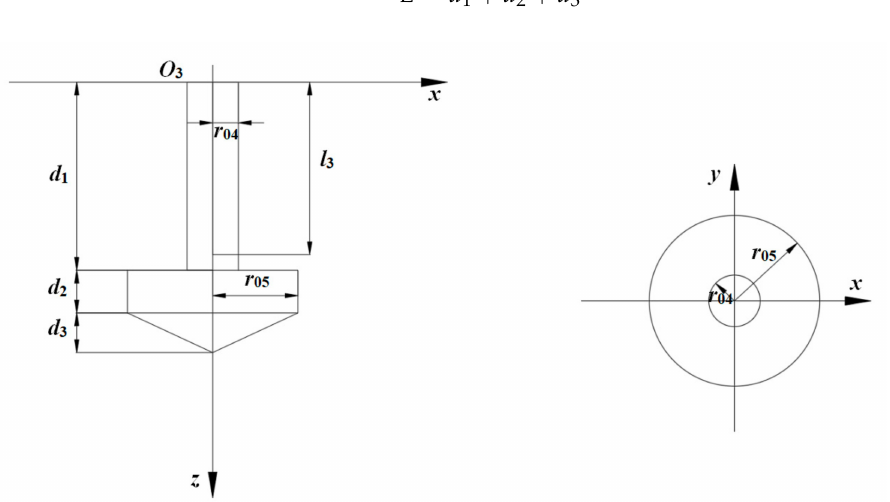
Figure 12. Structure of the swing